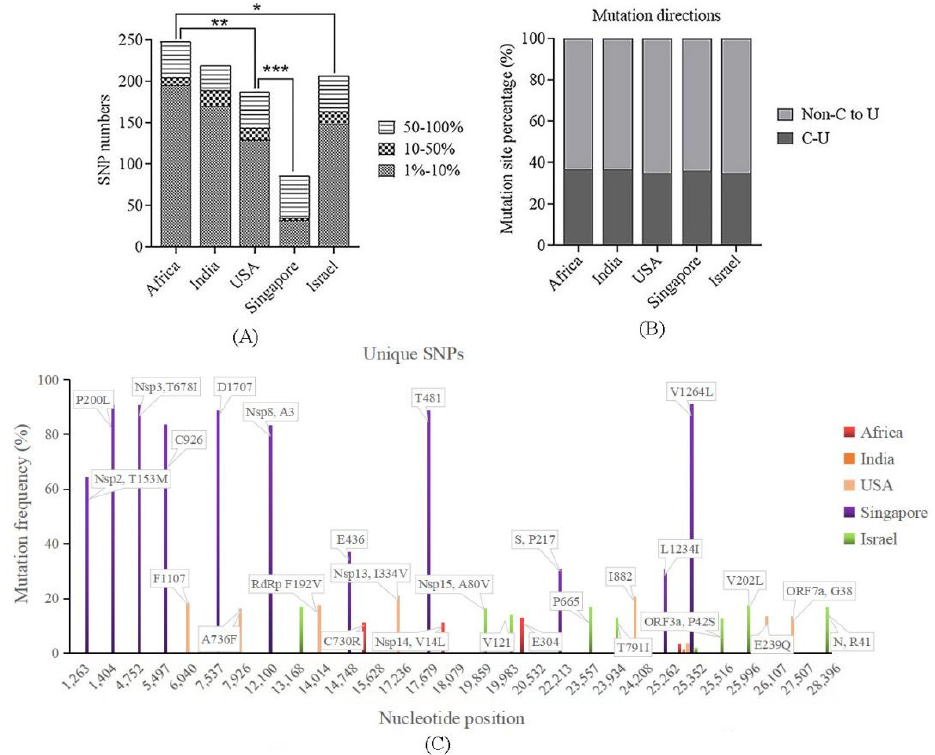
Figure 3. Single nucleotide polymorphism (SNP) distributions. ( A ) Numbers of SNPs in different countries/regions. Africa had the most SNPs, while Singapore had the least. *, p < 0.05; **, p < 0.01; ***, p < 0.001. ( B ) Mutation directions of Non-C to U and C to U. The proportion of C to U mutations in all five countries/regions was similar (around 36%). ( C ) Unique SNPs with a frequency >10% in the different areas. A total of 27 unique sites were detected, with Singapore having the largest number and the highest-occurring frequency.